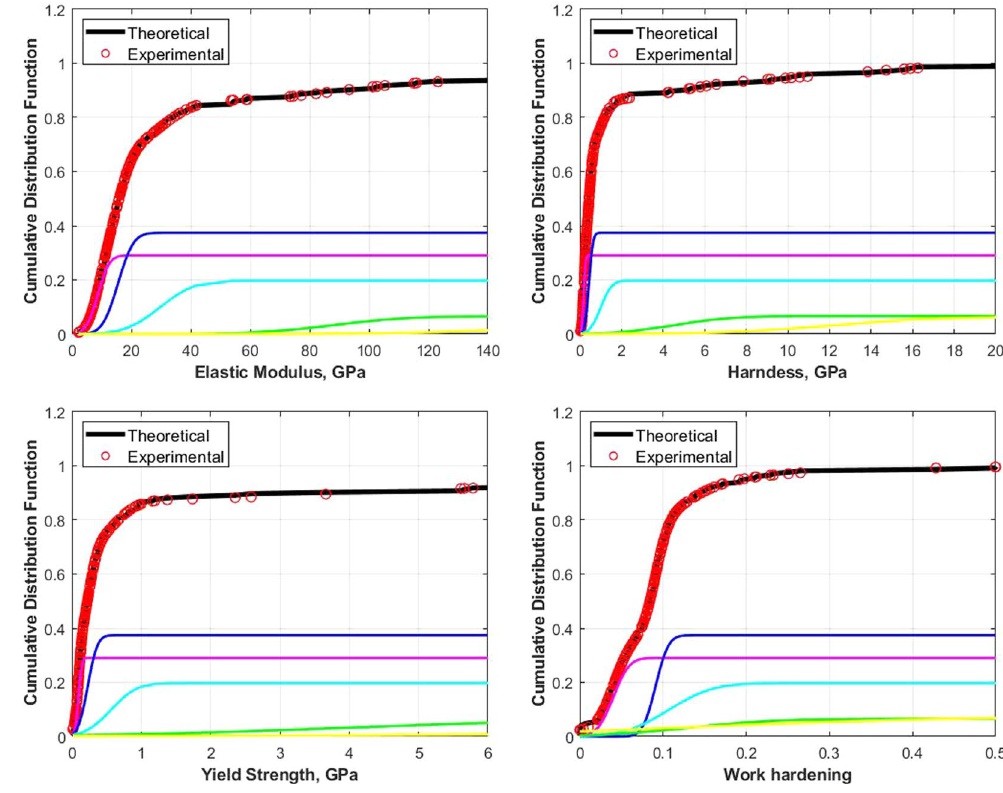
Figure 8. Deconvolution results of OPC paste.